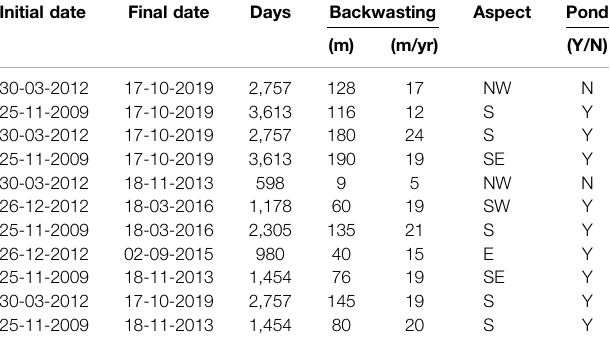
TABLE 4 | Persistent and backwasting ice cliffs on Verde glacier, listed from north to south. The ‘ Pond ’ column indicates the presence (Y) or not (N) of a coalescent pond at any stage of the backwasting